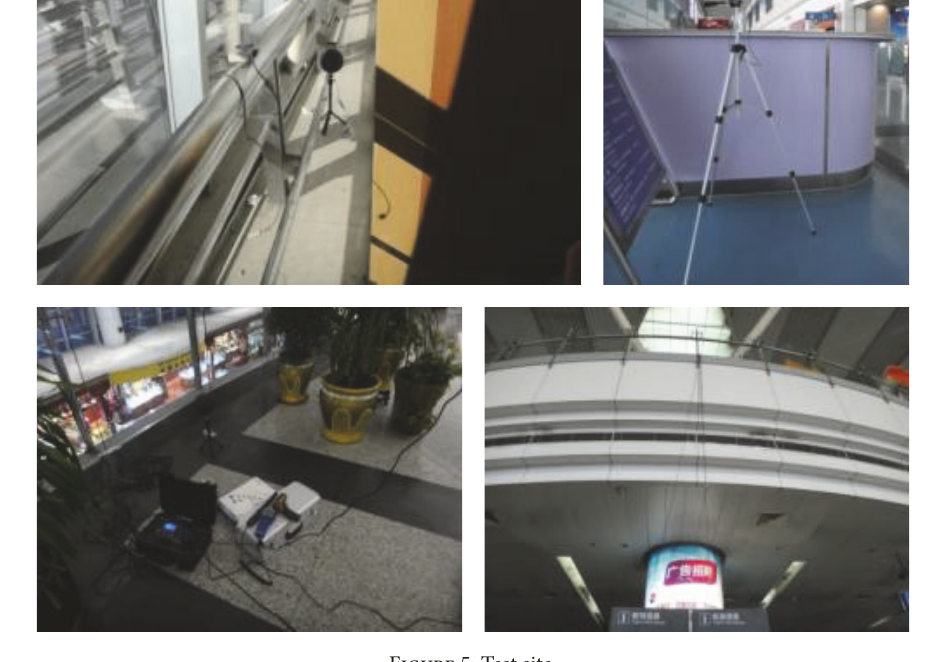
Figure 5: Test site.